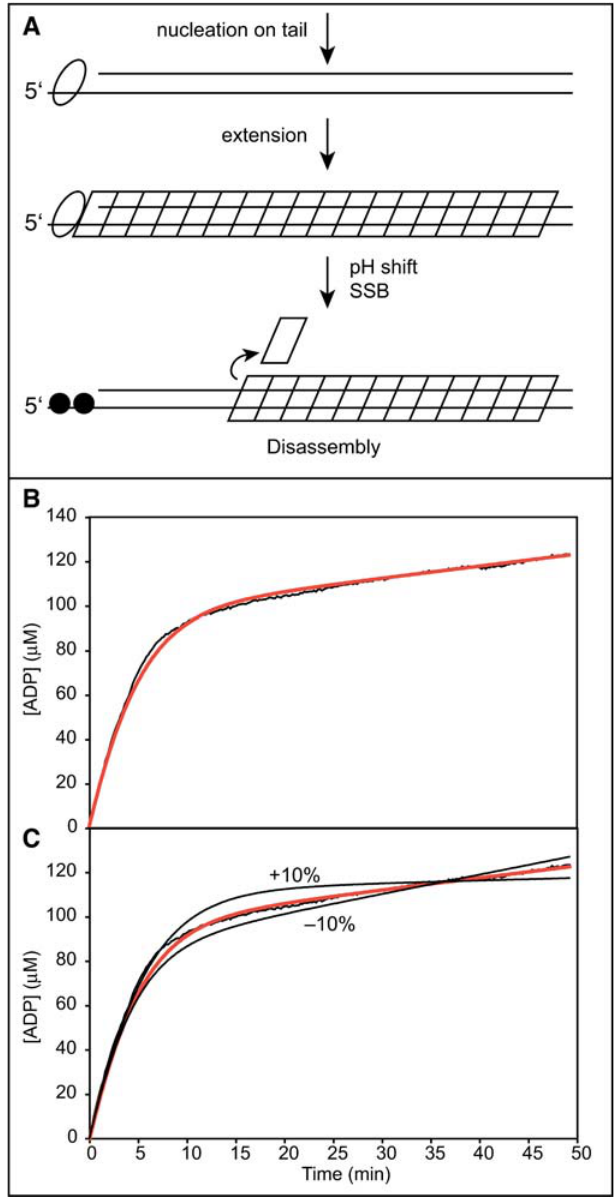
Figure 7. Quantitative Measurement of RecA Filament Disassembly from dsDNA (A) The experimental protocol, as described in the text. (B) A typical disassembly curve. The black line is the measured ADP production curve. The orange line is the fitting of the data by equation 1. (C) The curve is identical to that shown in panel B for the 3-kbp DNA substrate, with the best fit line shown in orange. However, two additional curves (in solid black) are shown to illustrate the variation in fitting if the value of k off is constrained to values 10% above or 10% below the best-fit determination. DOI: